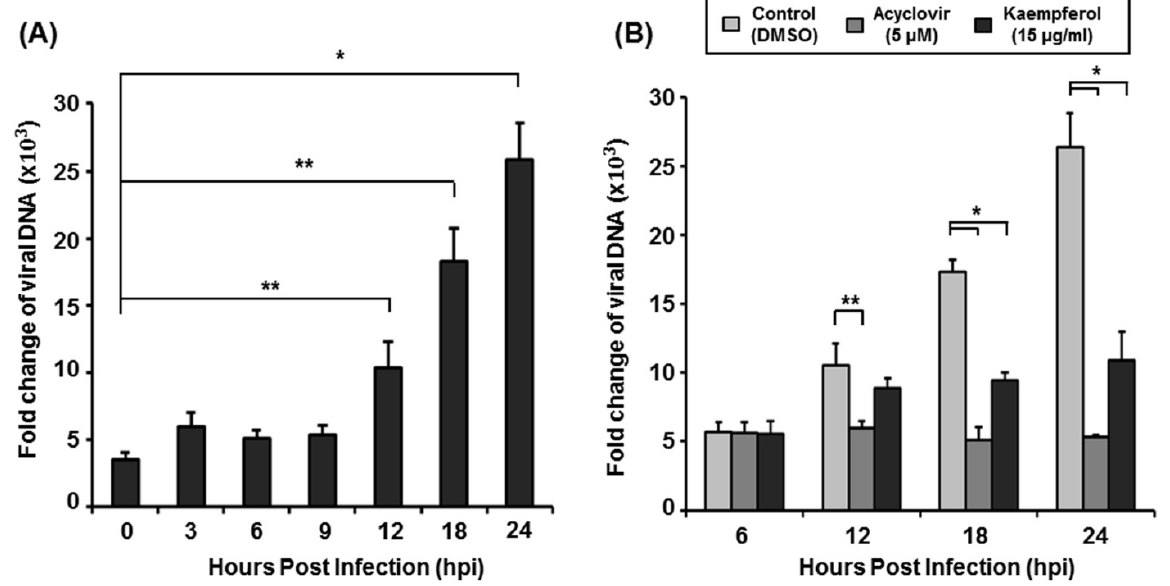
Figure 5. Analysis of the amount of VZV DNA replication. ( A ) HFFs were inoculated with cell- associated VZV-YC01 at a MOI of 0.1 and harvested at 0, 3, 6, 9, 12, 18, and 24 h. ( B ) VZV-YC01– inoculated HFFs were treated with kaempferol (15 µg/mL), acyclovir (5 µM), or DMSO, and harvested at 0, 6, 12, 18, and 24 h. Total DNA was extracted from nuclei of VZV-infected cells and relative amounts of viral DNA were determined by qPCR as above. Experiments were performed in triplicate, and values were expressed relative to those in uninfected cells (defined as 1). * p < 0.005, ** p < 0.05 (Student’s t -test).